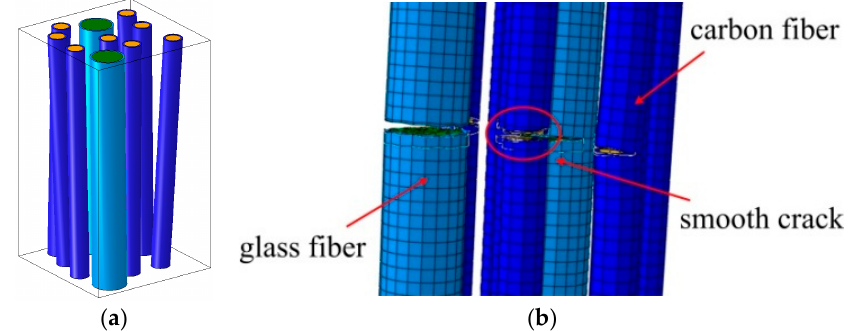
Figure 4. Micromechanical model of hybrid glass/fiber composites ( a ); and the simulated fiber failure ( b ). Reprinted from [41,42] with kind permission from Elsevier